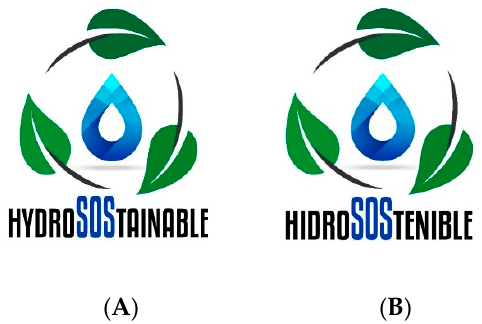
Figure 1. HydroSOStainable logo. (A): English version. (B): Spanish version.